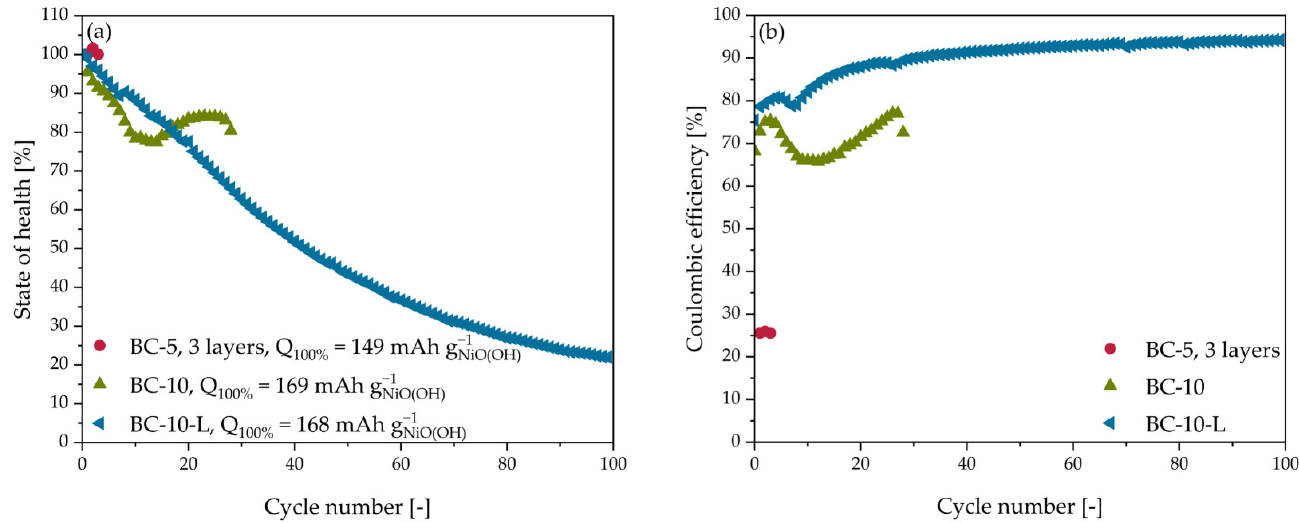
Figure 6. Comparison of produced bacterial cellulose (BC) separators in a Ni-Zn battery by their ( a ) state of health and ( b ) coulombic efficiency during electrochemical cycling at 1C.